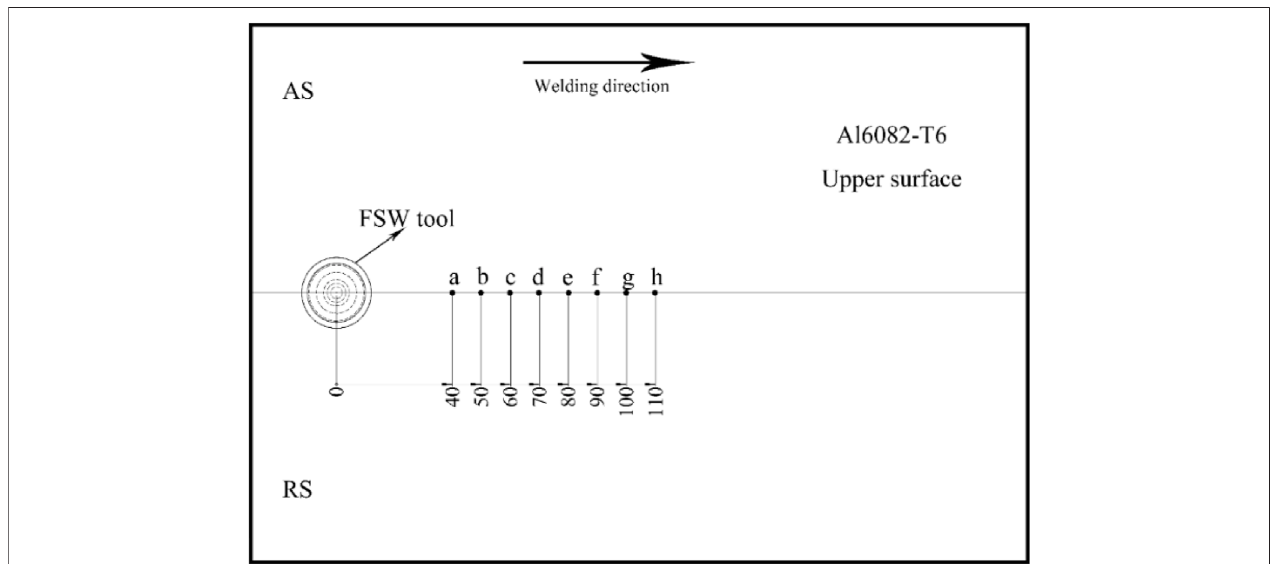
FIGURE 11 | Distribution of the longitudinal feature points at the weld center on the upper surface of the workpiece.